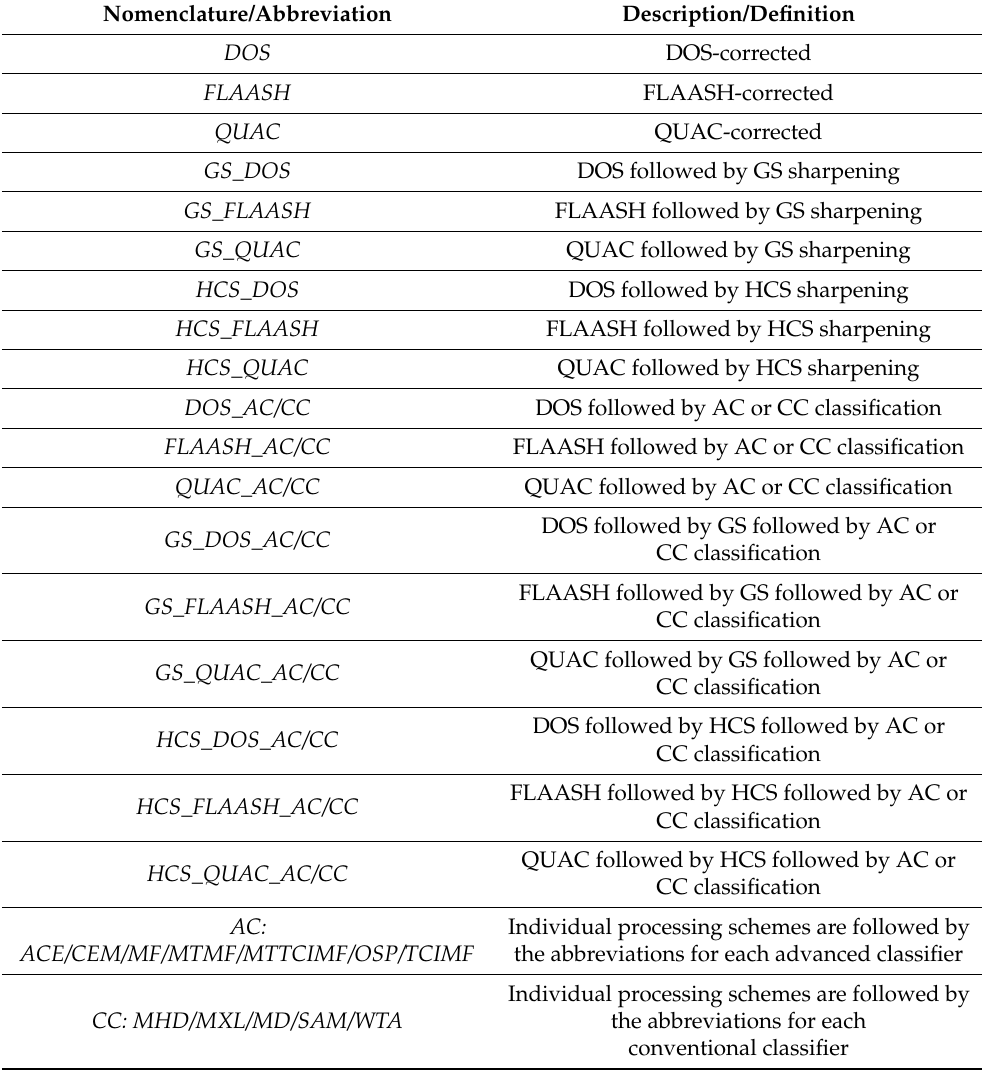
Table 2. Nomenclature of processing schemes used in the current study. AC: Advanced Classifiers; CC: Conventional